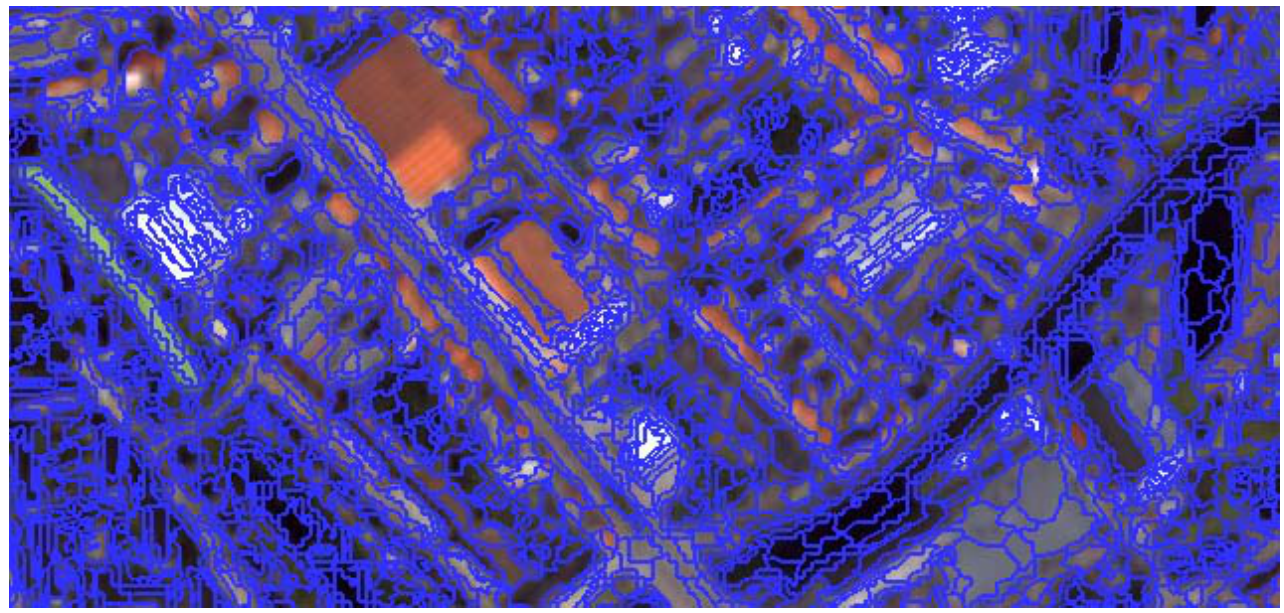
Figure 2. Segmentation of non-red surfaces for a subset of the study area (step two of the segmentation